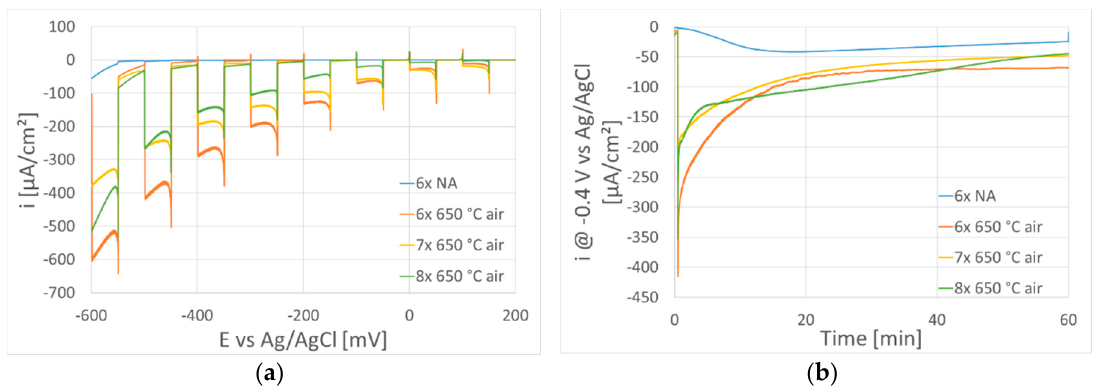
Figure 6. Linear voltammetry ( a ) and chronoamperometry ( b ) of samples 6x, 7x ,8x after post deposition annealing in air.